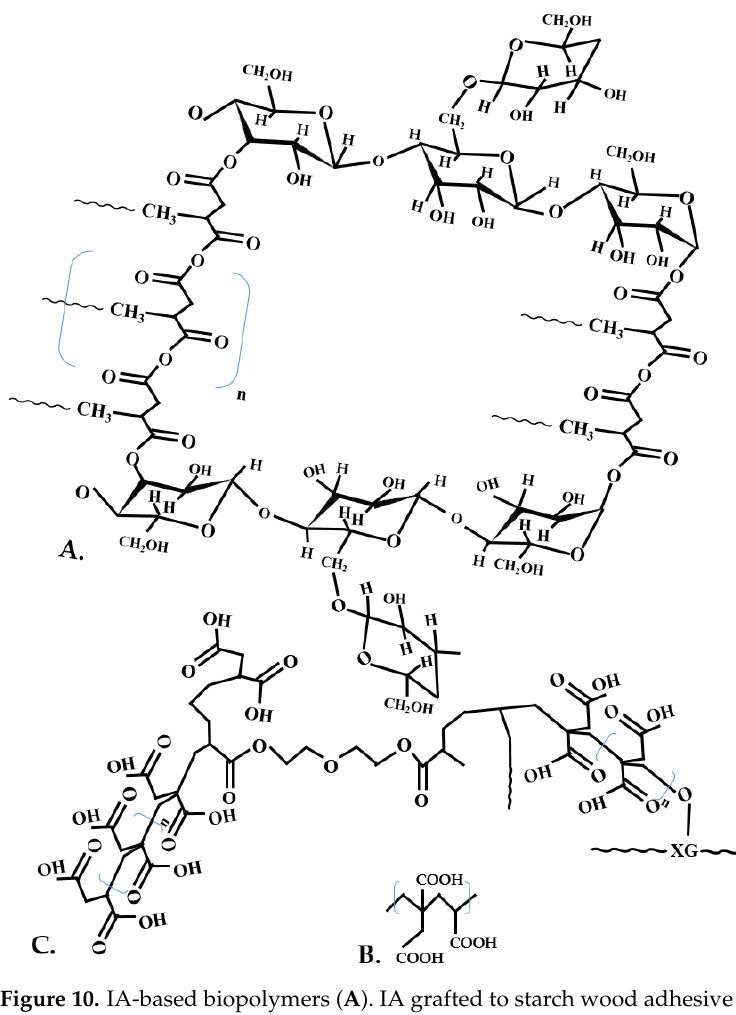
Figure 10. IA-based biopolymers ( A ) . IA grafted to starch wood adhesive (adapted after [165]) ( B ). P(IA–AA) (adapted after [166]) ( C ). Crosslinked XG–g–PIA (adapted after